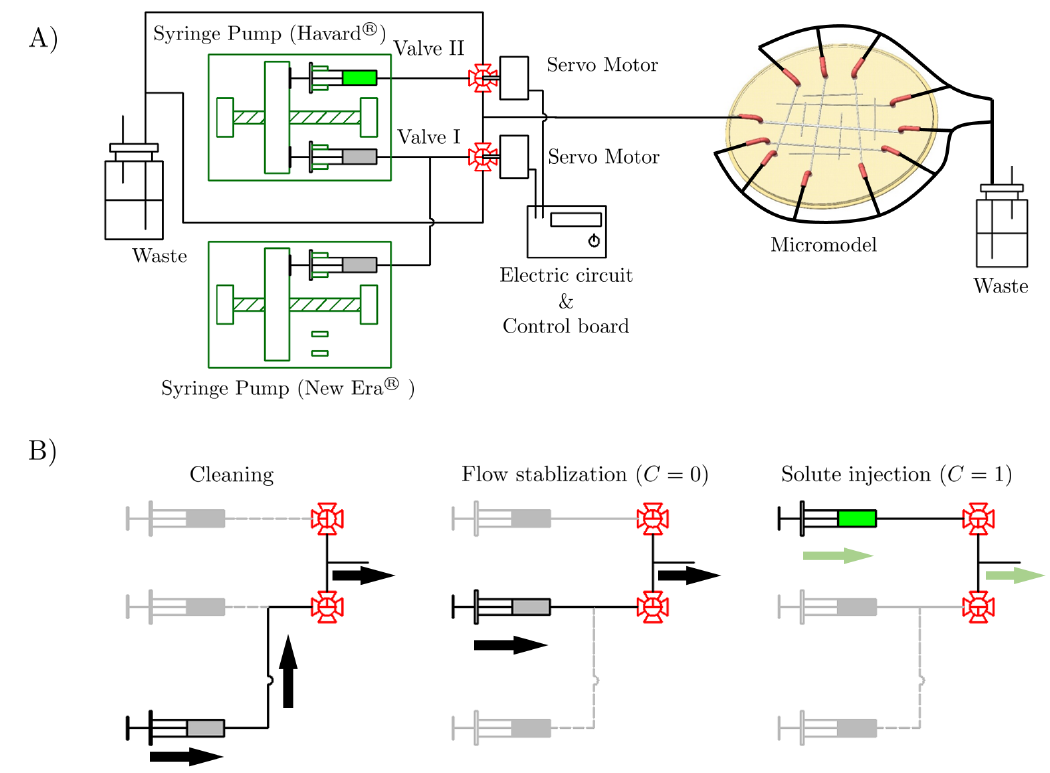
Figure 3. Experimental setup: ( A ) injection and tubing system; ( B ) injection patterns; and imaging system and photograph of actual